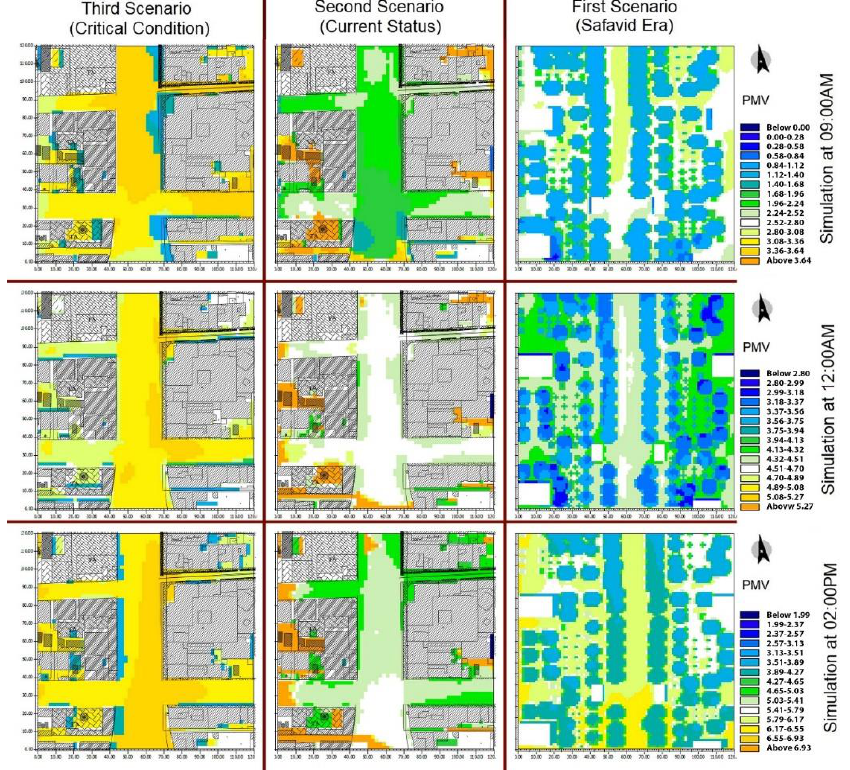
Figure 8. Comparison of thermal comfort in the three scenarios during different hours of the day.